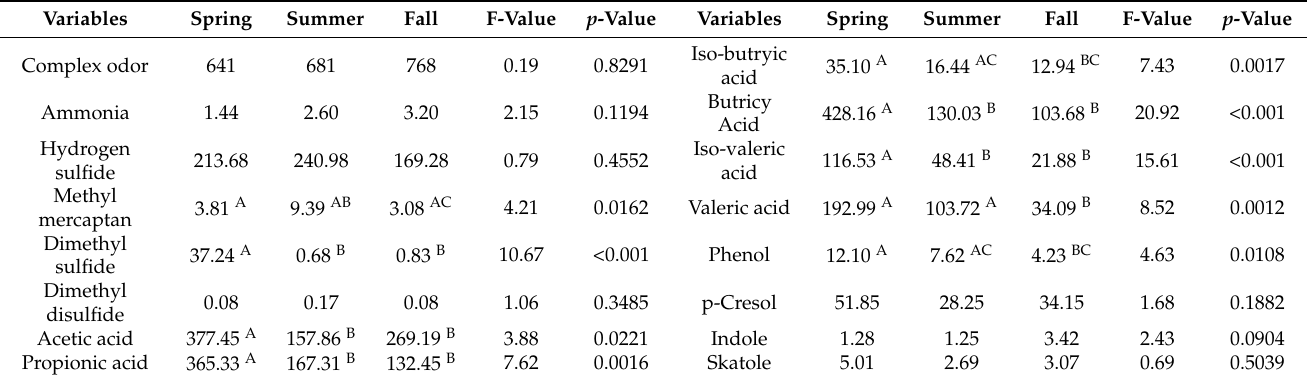
Table 7. Analysis of variance results for season. The subscripts ( A , B , C ) above the numbers grouped the mean of each category in the case of variables with significant differences in mean.